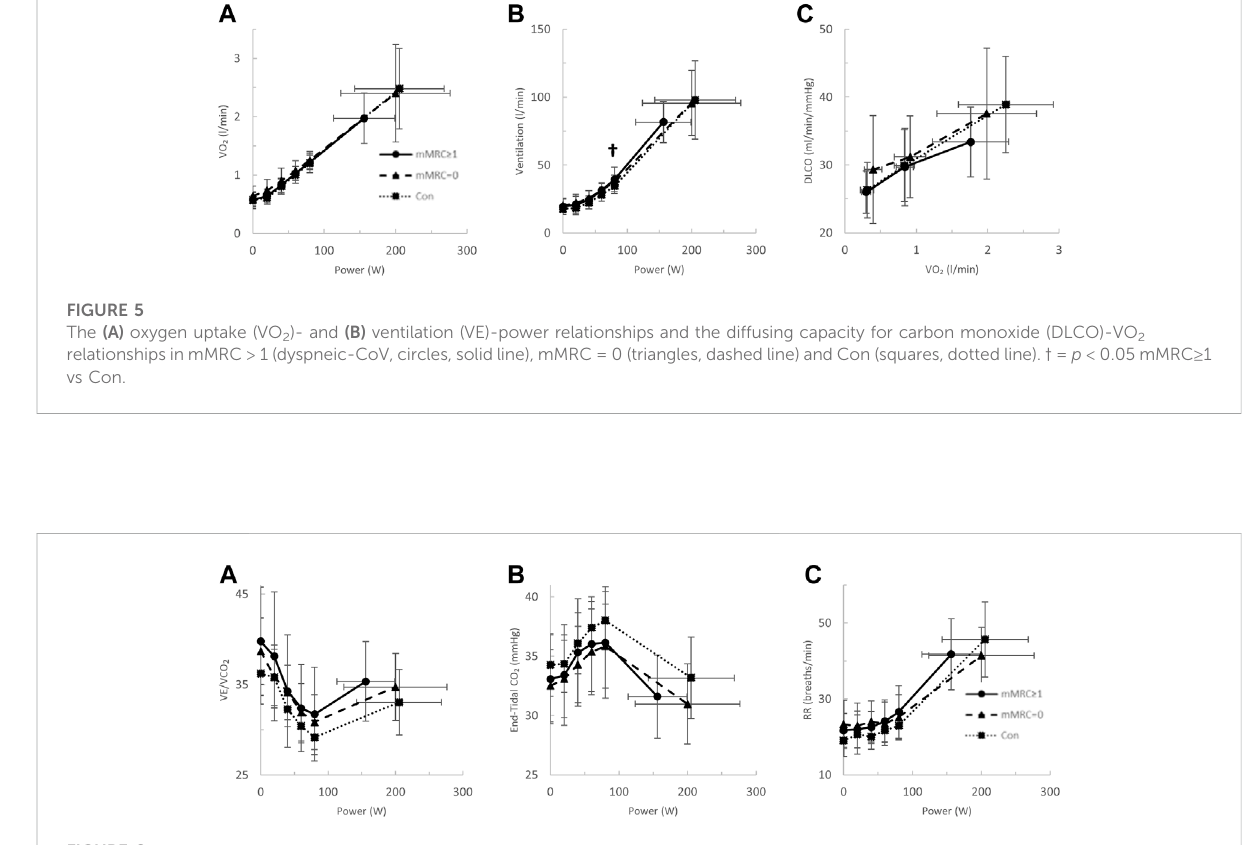
FIGURE 6 The ventilatory ef fi ciency- (VE/VCO 2 , (A) , end-tidal CO 2 - (B) and respiratory rate- (RR, (C) power relationships in mMRC ≥ 1 (dyspneic-CoV, circles, solid line), mMRC = 0 (triangles, dashed line) and Con (squares, dotted line). No signi fi cant differences.